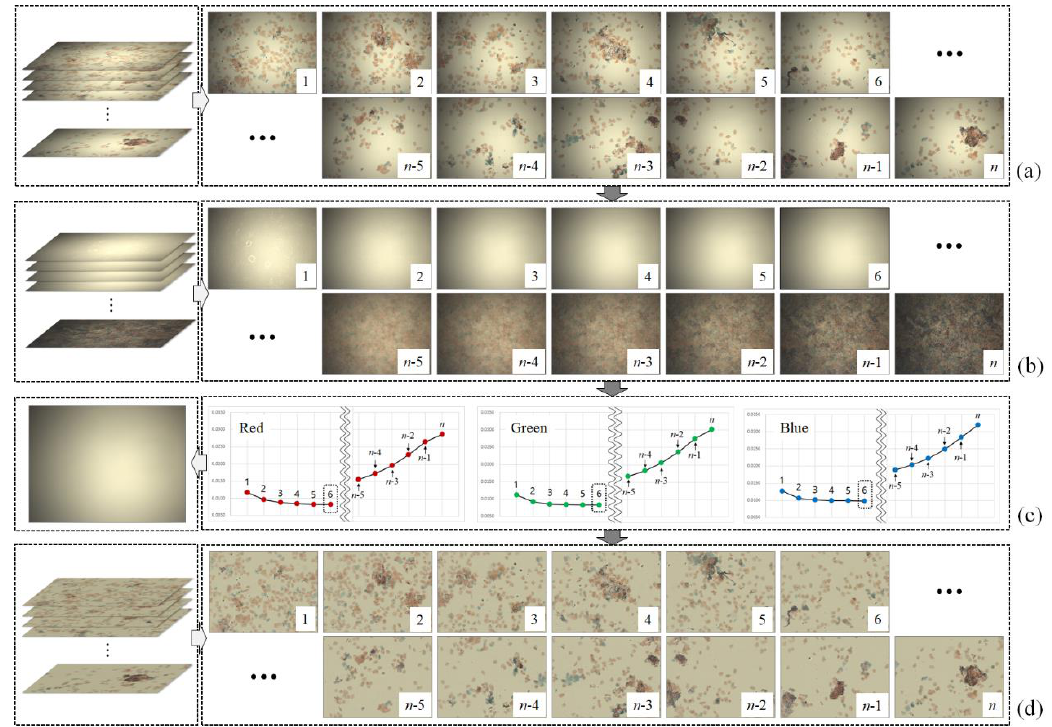
Figure 2. Flow of the proposed method: ( a ) input image sequence, ( b ) candidates of flat-field distortion, ( c ) selected flat-field distortion and ( d ) corrected image sequences.